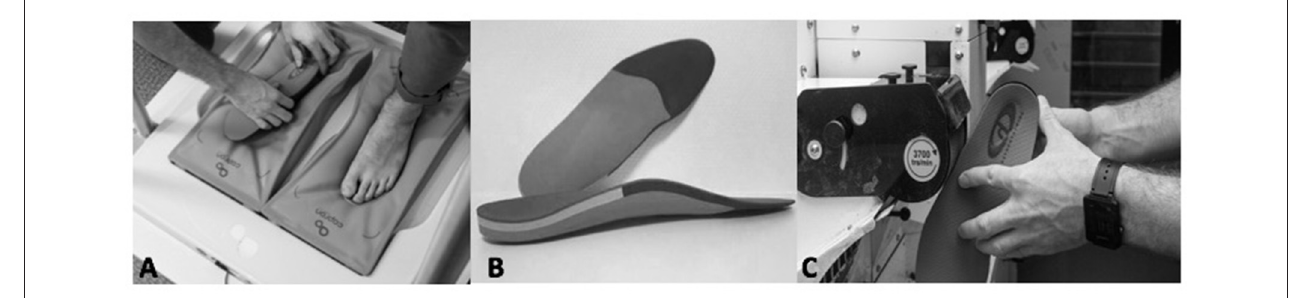
FIGURE 2 | Thermoforming the orthotic insoles (A) . Orthotic insoles in ethinyl vinyl acetate, resin, and polyethylene (B) . Further shaping the orthotic insoles (C) .